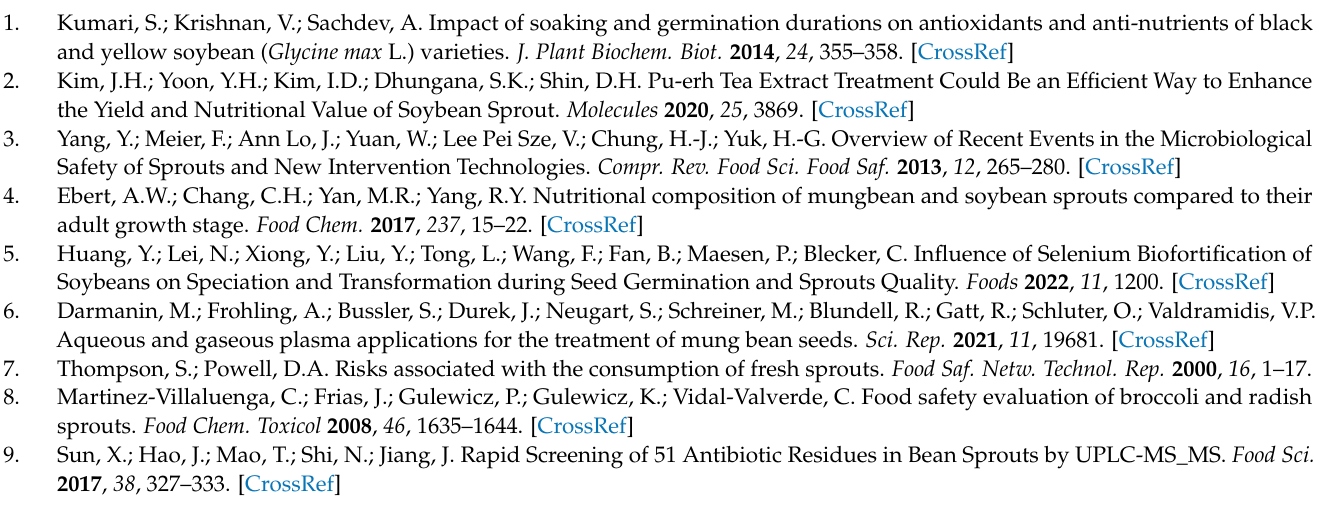
Figure S1: The 16 quinolones of MRM chromatogram; Figure S2: The effect of extraction solvents on the recoveries of 16 quinolones; Figure S3: The effect of purification of column on the recoveries of 16